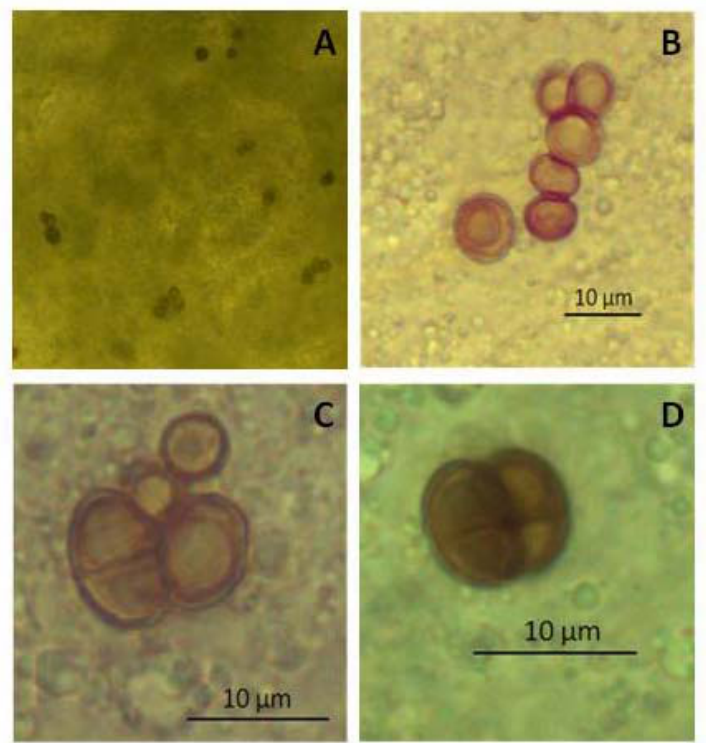
Figure 5. Sclerotic cells from footpad tissue samples obtained seven months after infection observed by direct examination; ( A ) 100x, ( B ) 400x, ( C and D )